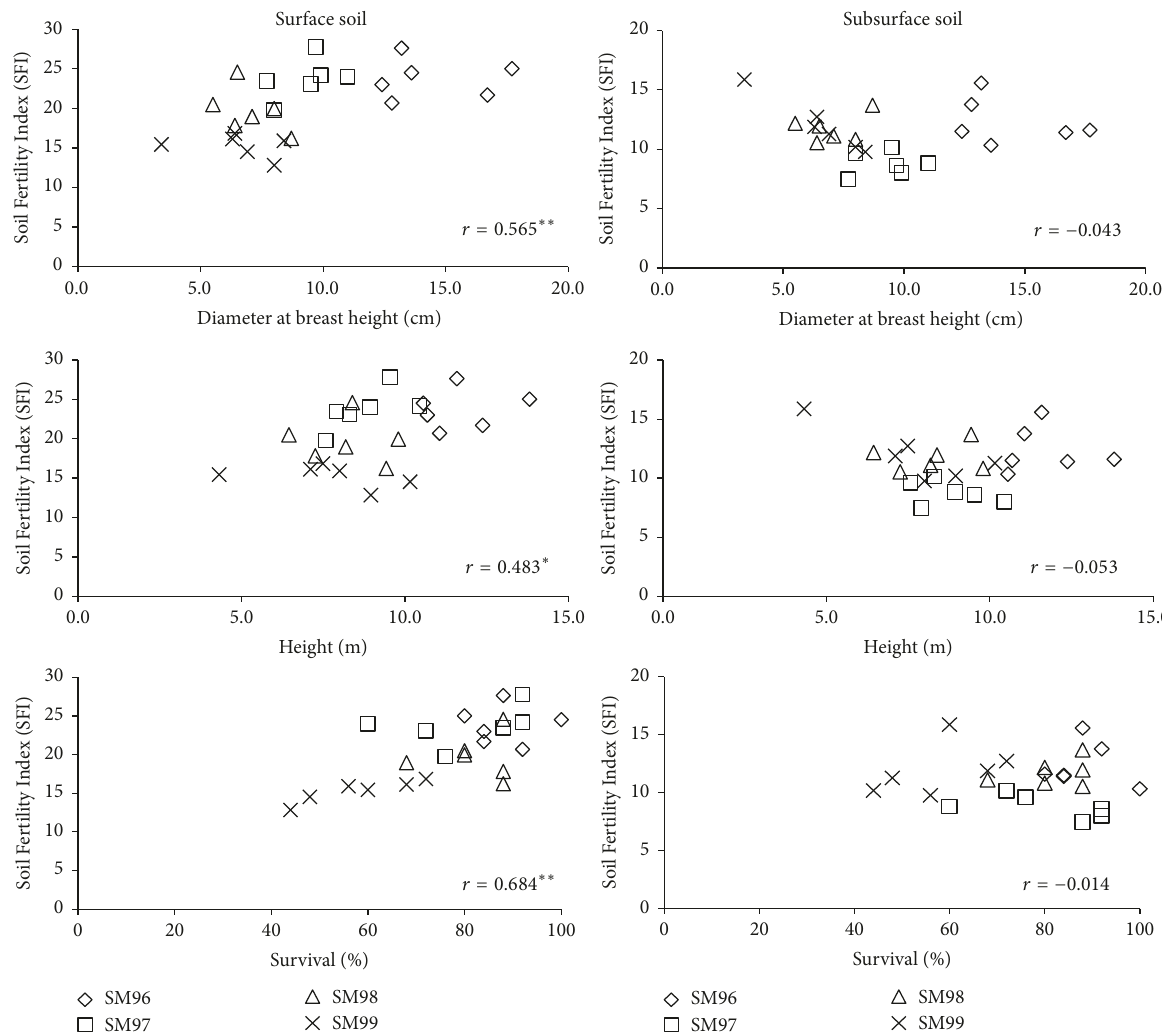
Figure 4: Relationship between diameter at breast height (DBH), height, and percentage of survival with Soil Fertility Index (SFI) derived from surface and subsurface soils. ∗,∗∗ Correlations are significant at 5% and 1% levels, respectively, using Pearson correlation